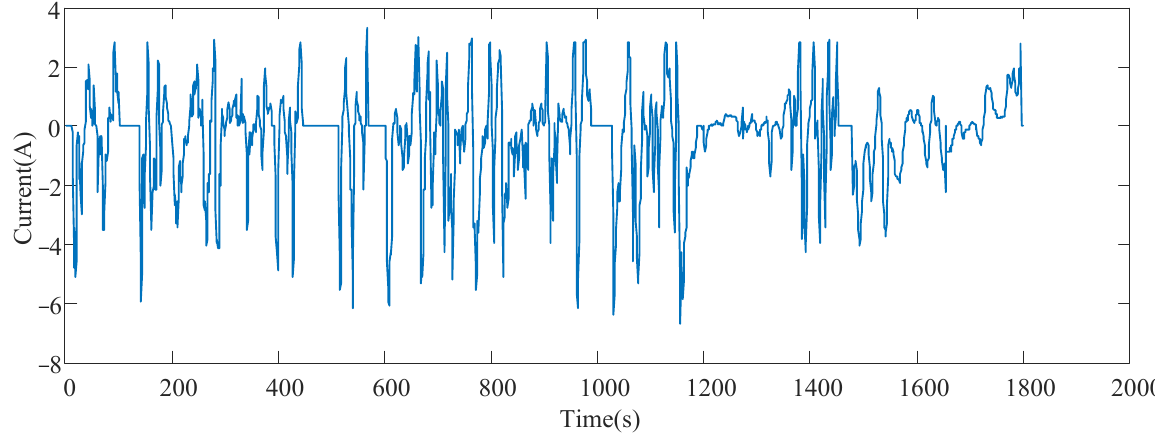
Figure 1. WLTC operating condition current. Table 2. The key parameters of the experimental battery.